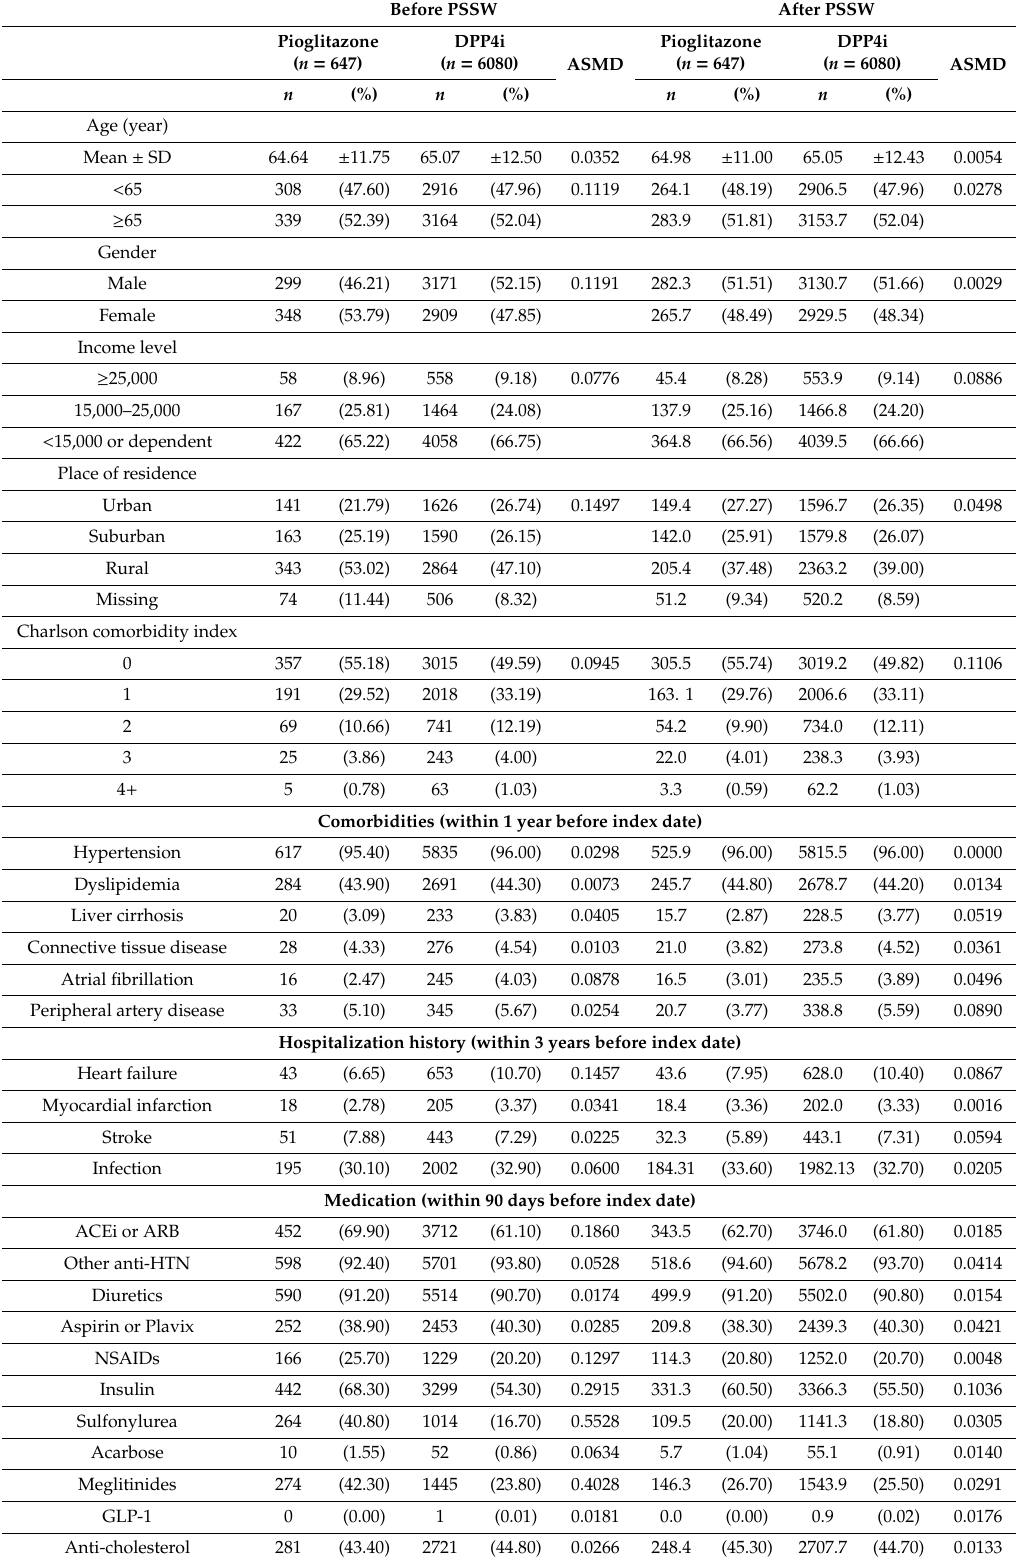
Table 1. Baseline characteristics of diabetic patients with end-stage renal